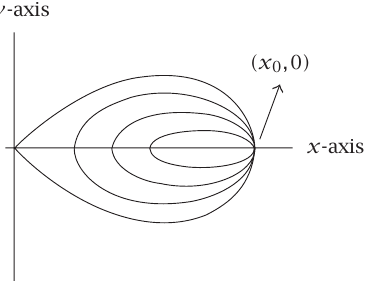
Figure 5.7 . The heteroclinic orbit filled by homoclinic